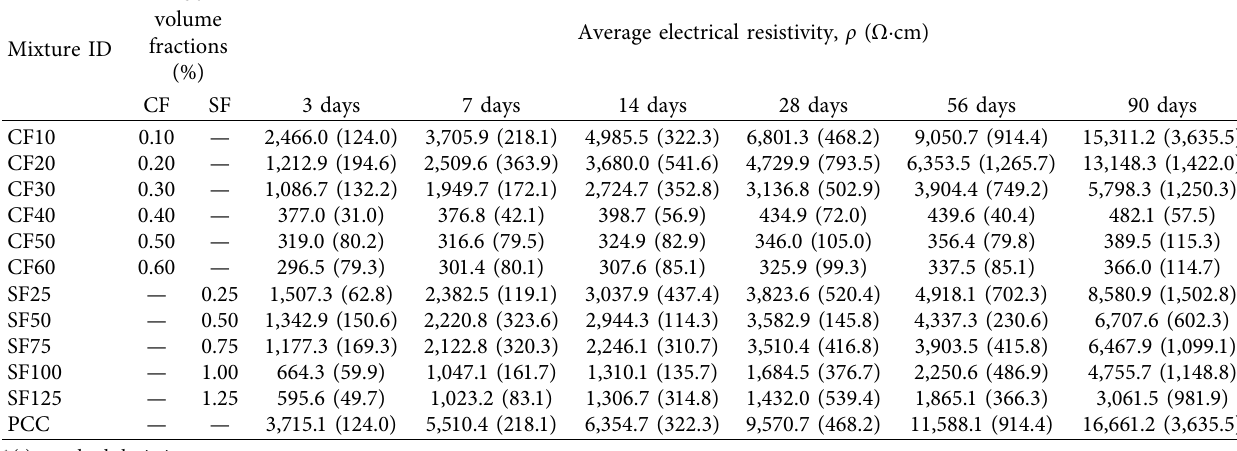
Table 5: Te results of average electrical resistivity measurement for the studied specimens.